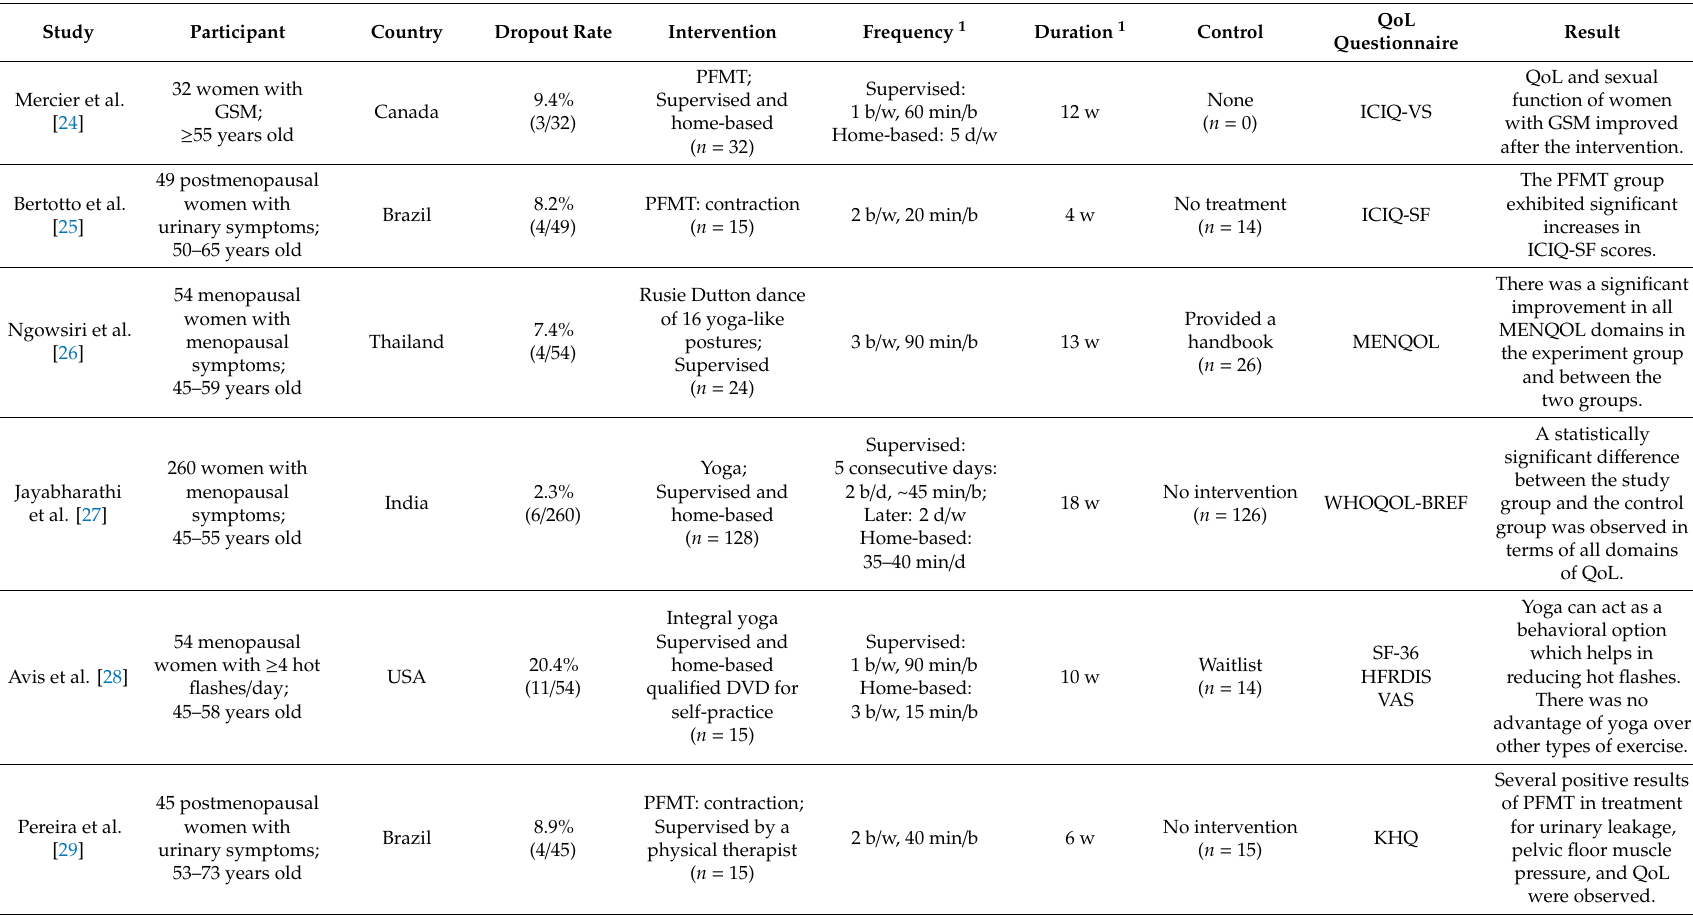
Table 2. Characteristics of the nine studies included in the qualitative